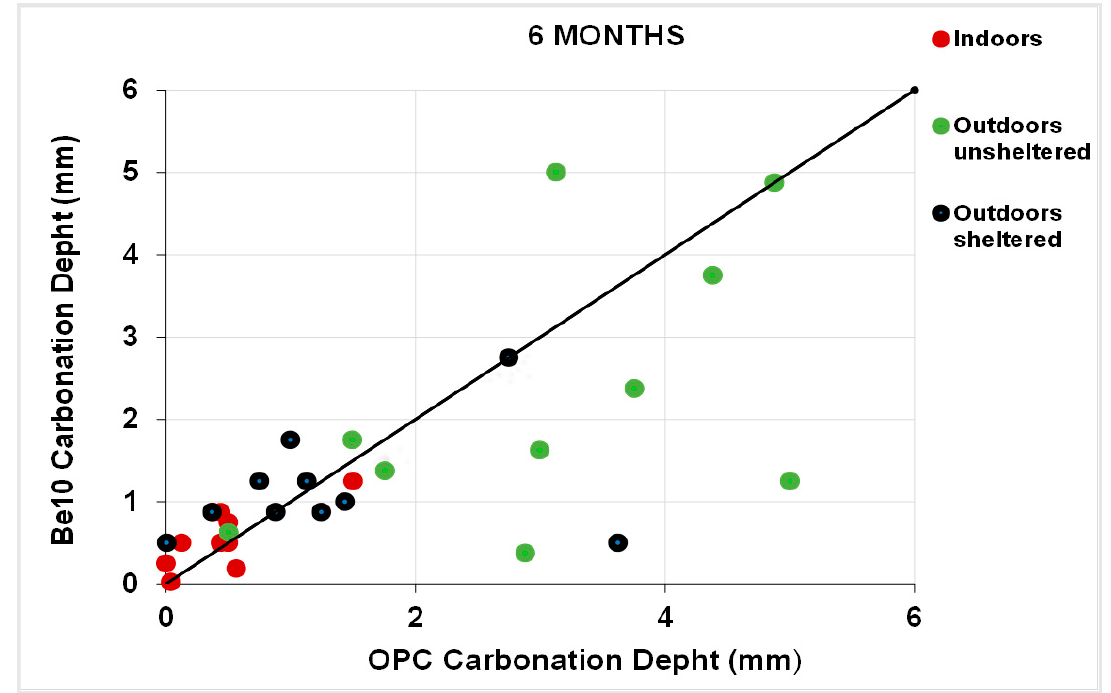
Figure 12 Figure 12. Six-month carbonation depth in reference OPC vs. 10% bentonite-bearing Be10. As a rule, the flexural strengths (Figures 13–16) were fairly similar in the reference and blended samples. The compressive strength values were even closer in the two types of mortars. Inasmuch as the experiment was designed for purposes of comparison,